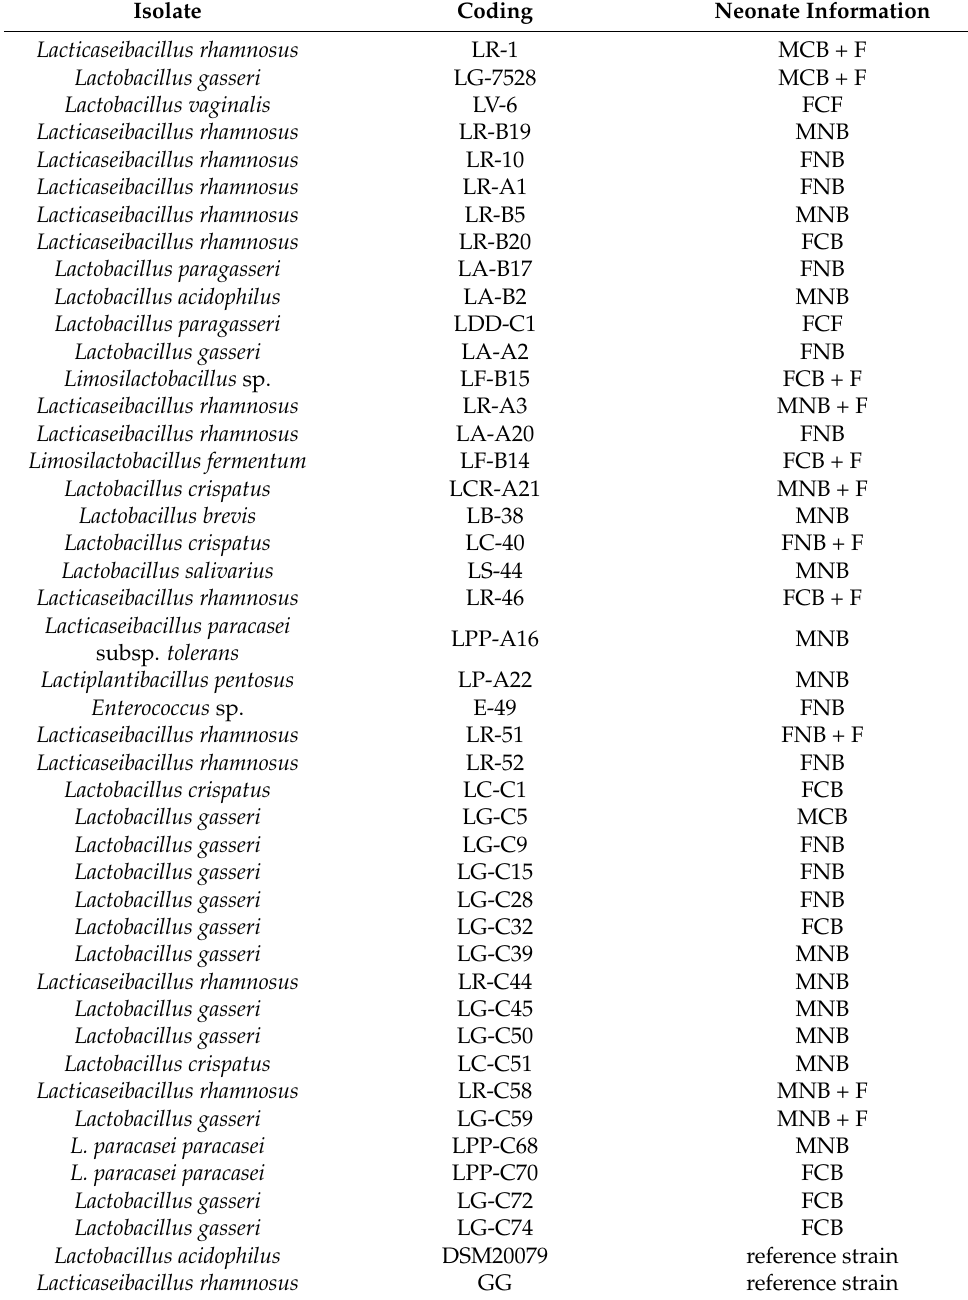
Table 1. Lactic acid bacteria strains isolated from neonate fecal samples used in the study.